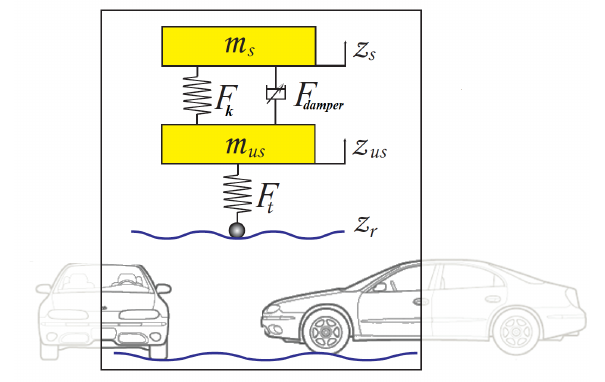
Figure 3. Quarter car model of an automotive suspension